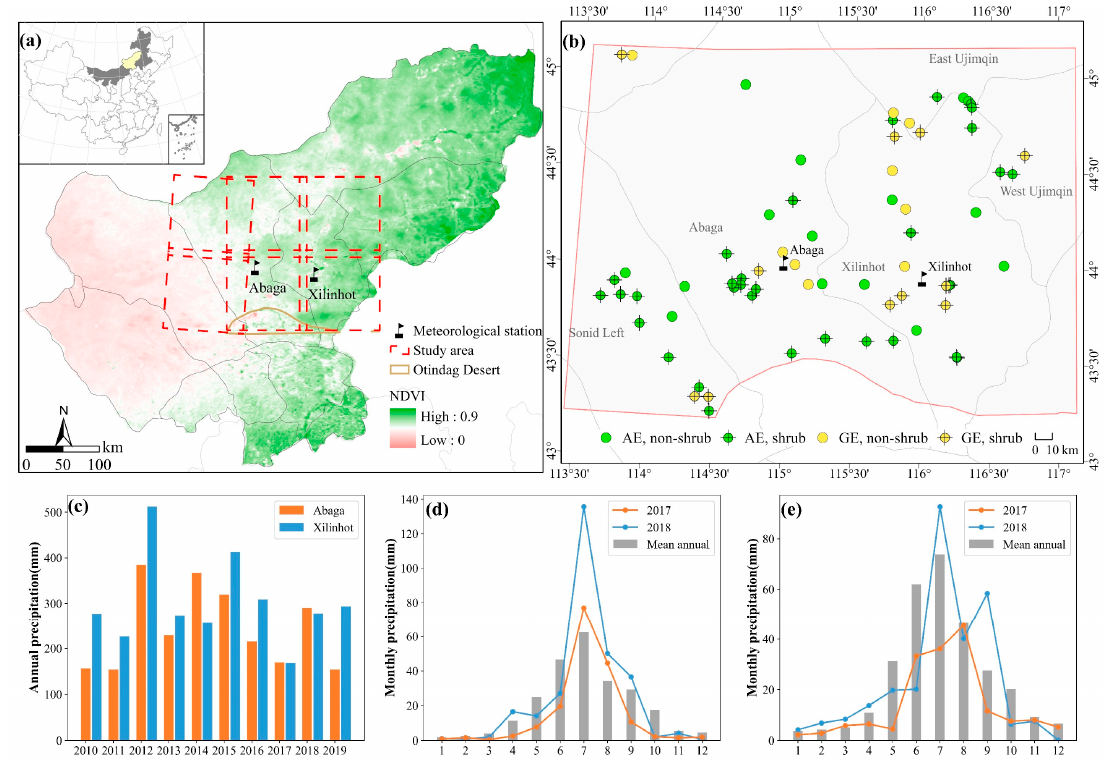
Figure 1. The location of the study area covered by six Sentinel scene footprints (red dotted boxes) in Xilin Gol League ( a ) and sampling sites from the Google Earth platform (GE) and aerial photos (AE) ( b ). Annual cumulative precipitation of meteorological stations from 2010 to 2019 ( c ), monthly accumulated precipitation at Abaga ( d ) and Xilinhot ( e ) stations.